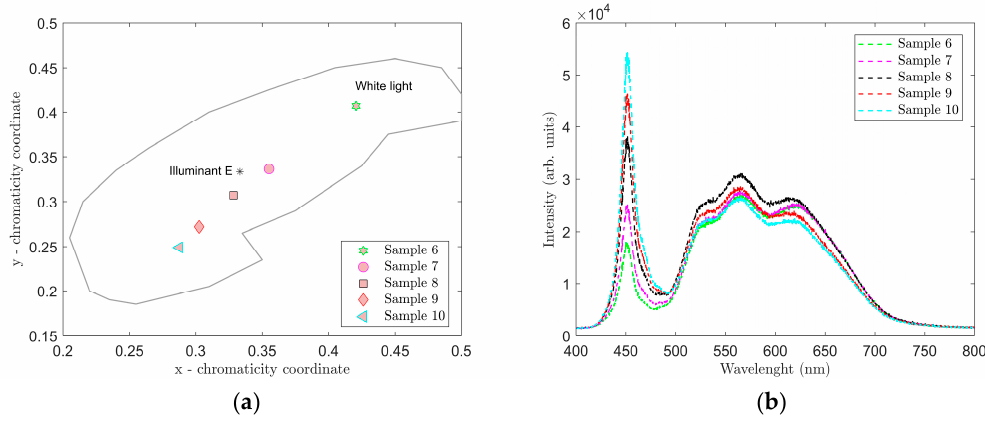
Figure 5. Measured CRI ( a ) and CCT ( b ) values for samples 1–5.